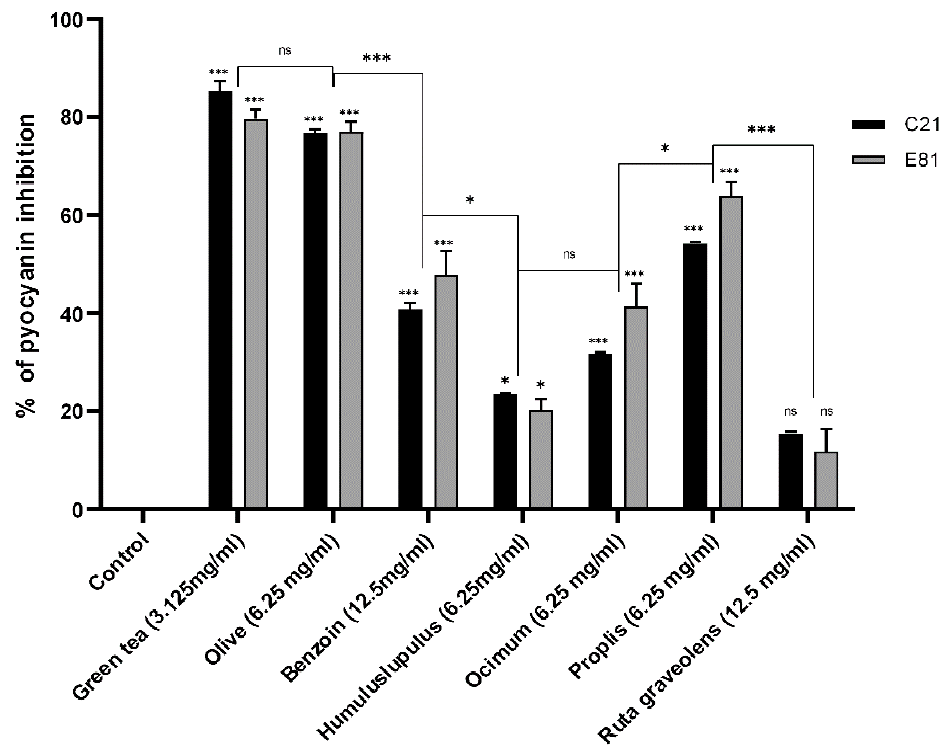
Figure 3. E ff ect of di ff erent herbal extracts on pyocyanin production of P. aeruginosa . Bar chart showing percent inhibition of C21 and E81 pyocyanin production in the absence and presence of herbal extracts Camellia sinensis (3.125 mg / mL), Olea europaea (6.25 mg / mL), Styrax benzoin (12.5 mg / mL), Humulus lupulus (6.25 mg / mL), Ocimum basilicum (6.25 mg / mL), Propolis (6.25 mg / mL), and Ruta graveolens (12.5 mg / mL). Pyocyanin production was evaluated by the chloroform-HCl extraction method. Data are an average of three independent experiments. The results are presented by the mean ± SD. ns = nonsignificant; * = p < 0.05; *** = p < 0.001: significance was compared to the respective control.